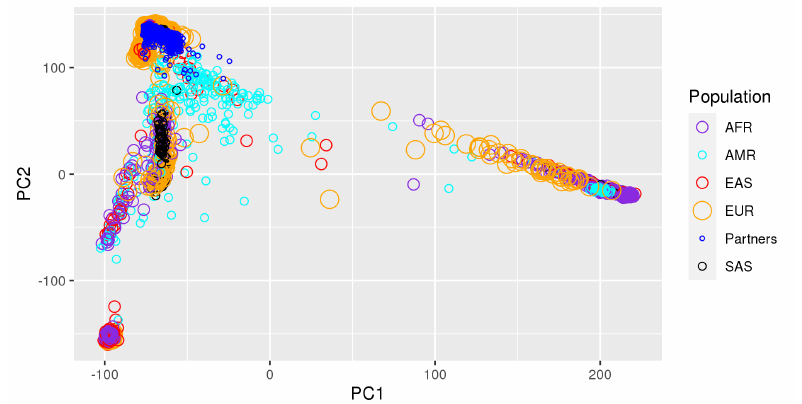
Figure A3. Using bigsnpr we have projected our dataset onto the reference 1000 Genomes populations. As the readers can see now, our dataset is clustered within the European population of 1000 Genomes. The population acronyms are: AFR (Africa), AMR (America), EAS (East Asia), EUR (Europe), SAS (South